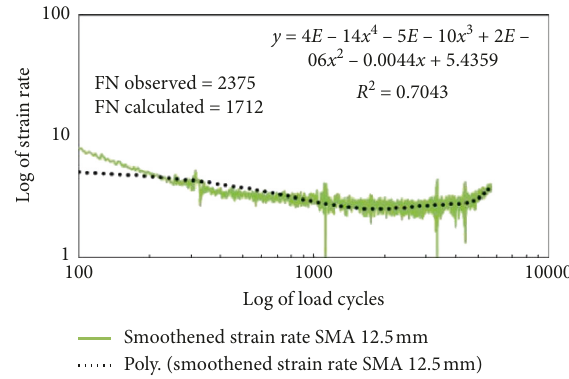
Figure 7: Data smoothening applied to 12.5mm Table 2: FN test results.